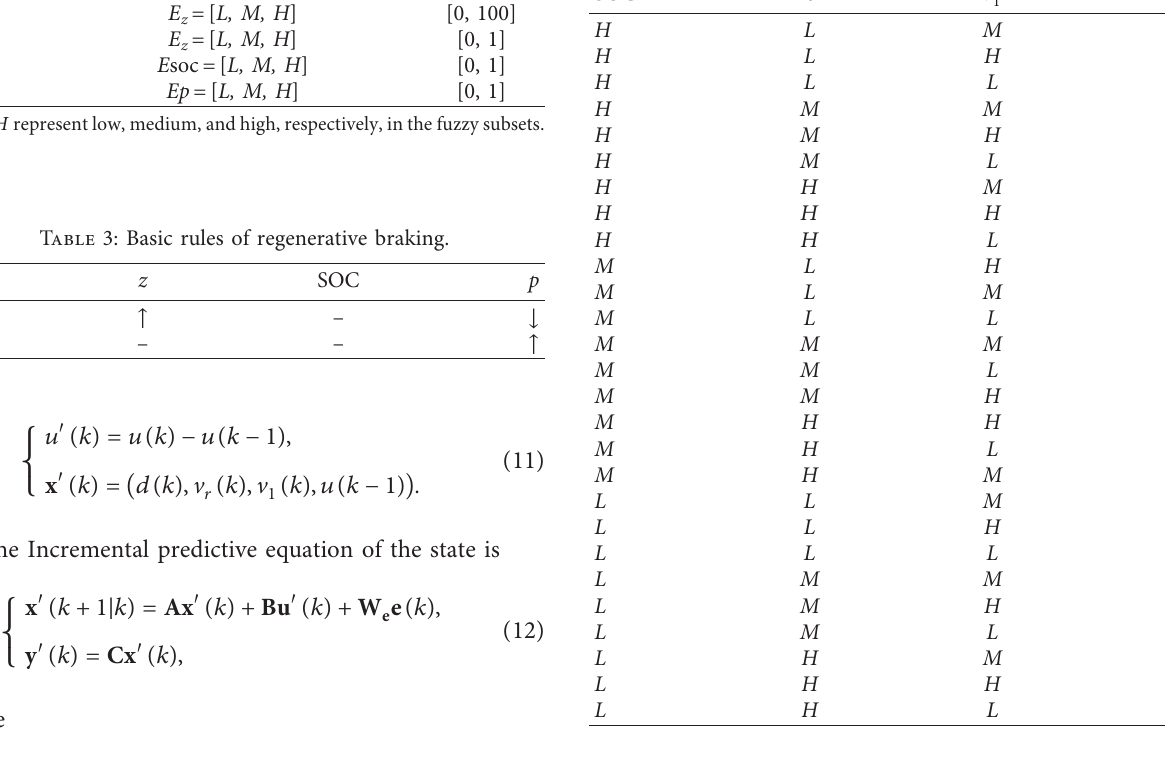
Figure 4: (a) The braking strength membership function curve. (b) The following-vehicle-speed membership function curve. (c) The membership function curve. (d) The driving wheel regenerative braking proportional coefficient membership function curve. Table 4: Fuzzy rules for the proportional coefficient of regenerative Table 2: Parameters of the fuzzy logic controller. Parameter